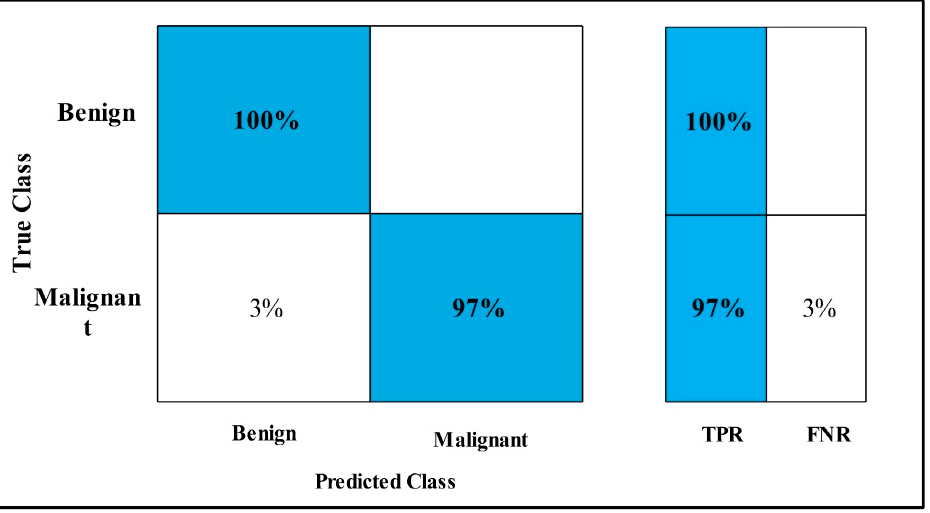
Figure 22. Fine-tuned Nasnet TPR for INbreast.